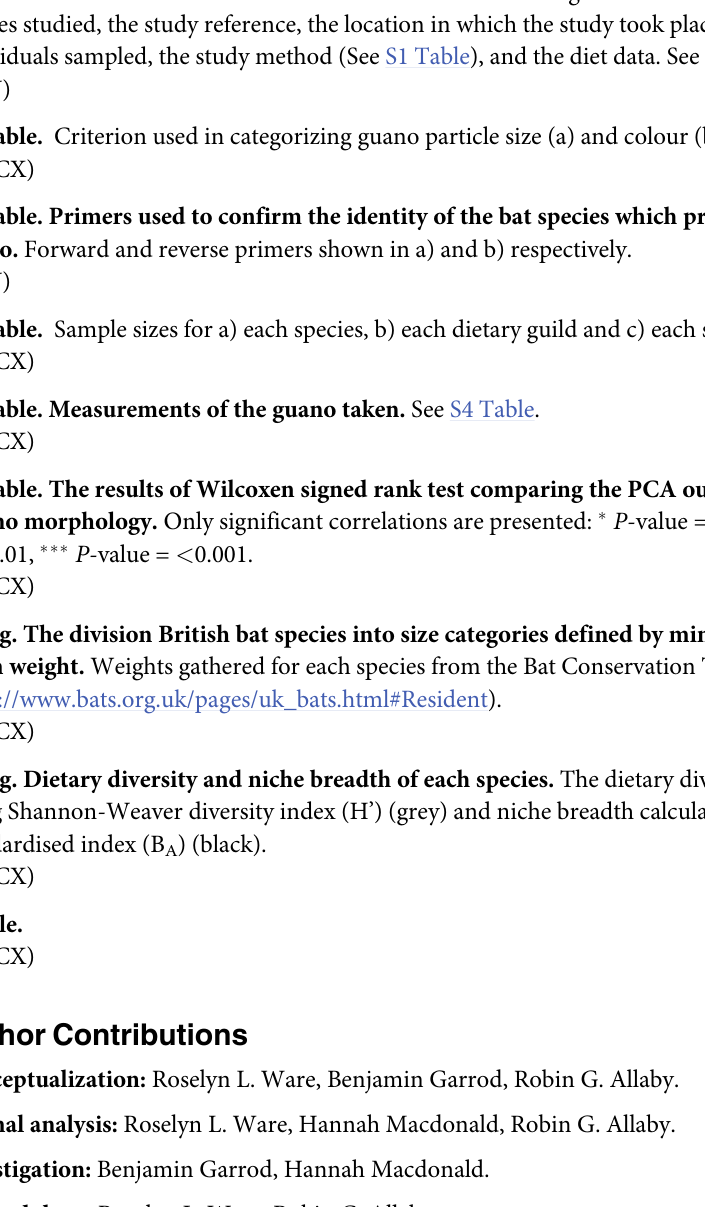
S2 Fig. Dietary diversity and niche breadth of each species. The dietary diversity calculated using Shannon-Weaver diversity index (H’) (grey) and niche breadth calculated using Levin’s standardised index (B ) A